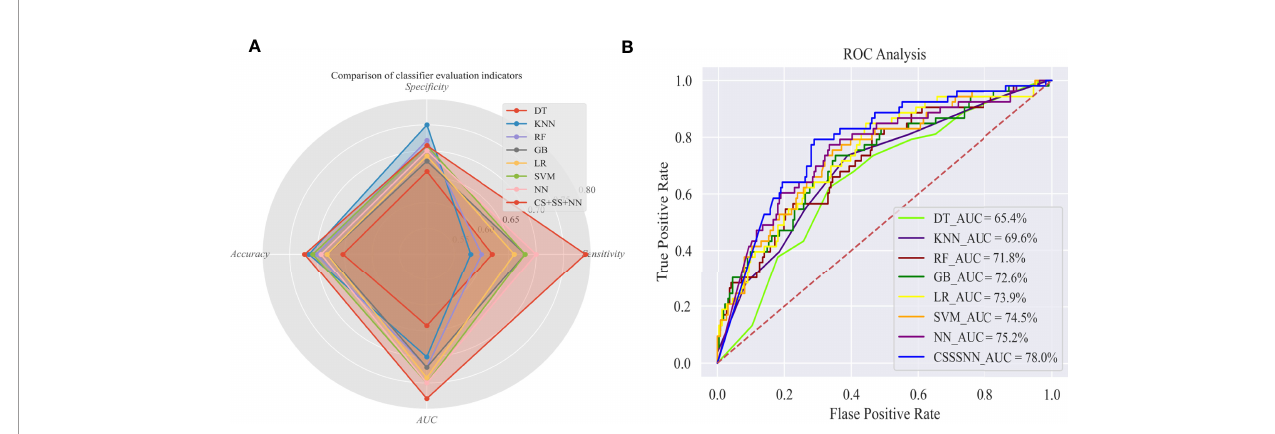
FIGURE 1 | Evaluation of survival outcome prediction models in Test set. (A) Comparison of classi fi er evaluation indicators; (B) ROC analysis. AUC, Area under the receiver-operator characteristic curve; DT, decision tree; KNN, k-nearest neighbor; RF, random forest; GB, gradient boosting; LR, logistic regression; SVM, support vector machine; NN, neural network; CS+SS+NN, cost-sensitive semi-supervised neural